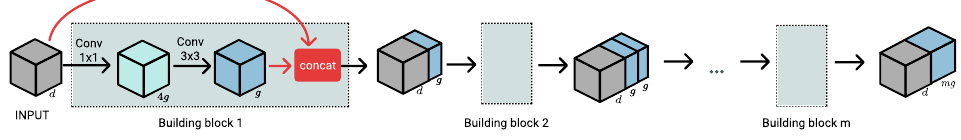
Figure 12. Dense block with m building